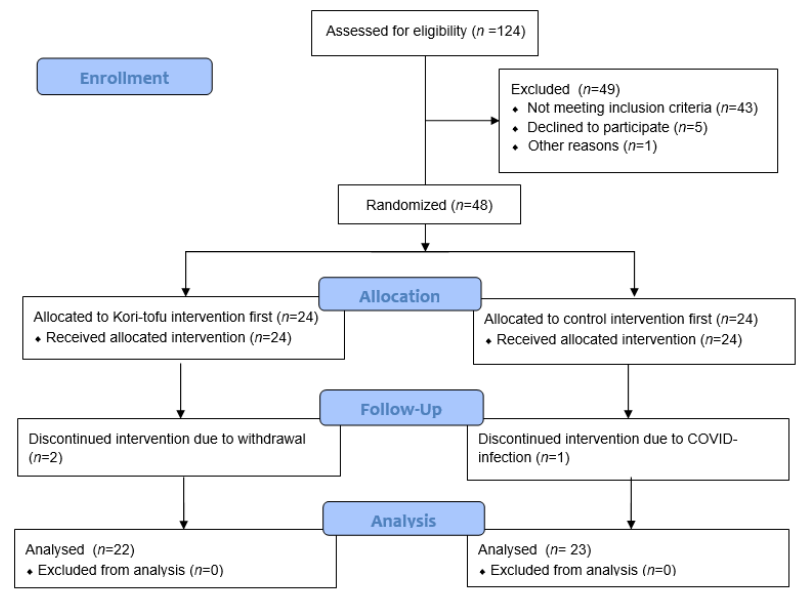
Figure 1. Flow-chart diagram of the participant selection and randomization